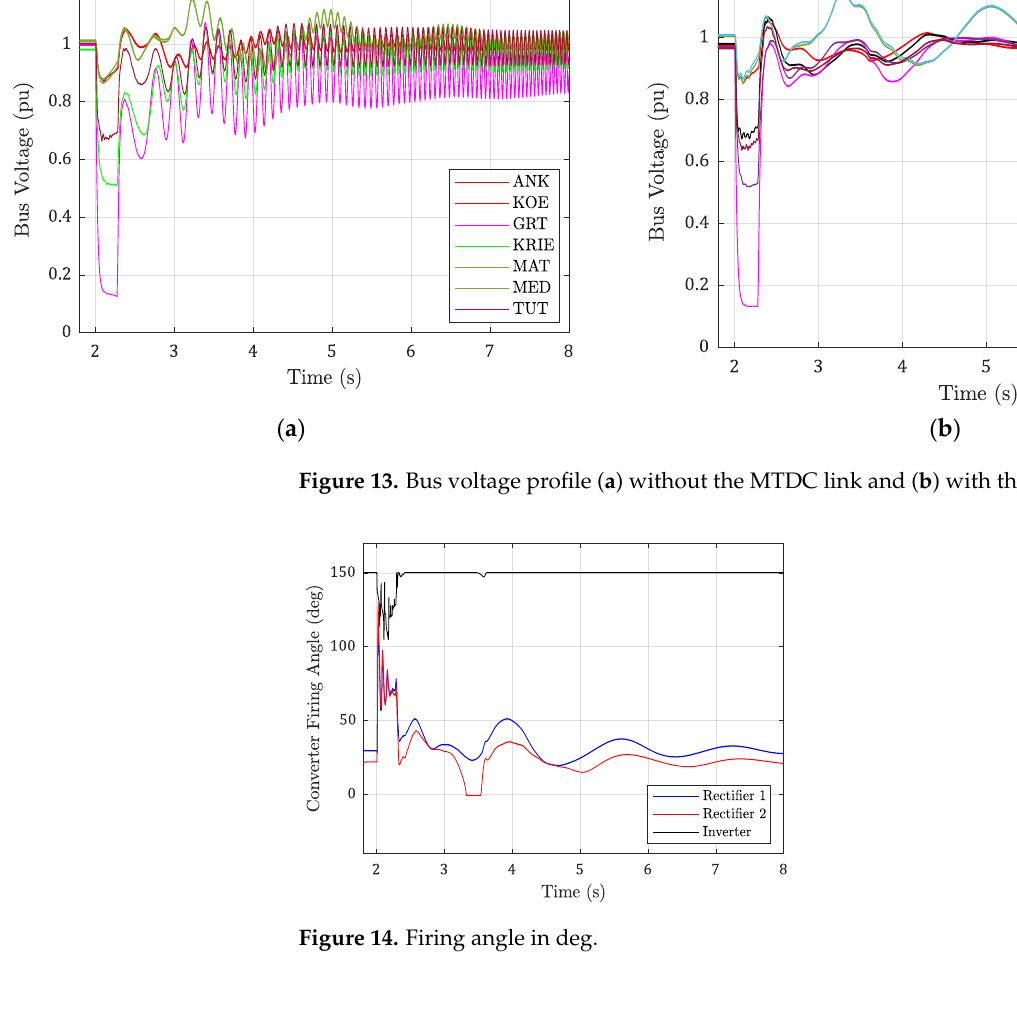
Figure 15. MTDC power where RP1 is rectifier 1 power, and ARP1 is rectifier 1 power with the auxiliary control. Figure 16. Interarea power transfer across the northern and north-east borders. Figure 11a,b show the generator rotor angle ( δ ) dynamics in radian. In Figure 11a, the GRT_PS synchronous generator was out of step from the rest of the synchronous machine. It recorded a rapid increase in the rotor angle, while other generators witnessed a steady increase with the continuous oscillation. These generators, having yielded their excitation and AVR controls, remained unsta- ble even after clearing the fault due to insufficient decelerating torque to reduce the rotor speed, i.e., the generators exhibited positive damping ( T D ) torque but with a negative syn- chronizing torque ( T S ), causing a non-oscillatory instability. The unstable state involving the rotor angle speed is usually referred to as electromechanical oscillations. The control systems are intended to restore the power system to stable conditions and to align the mechanical torque with the electromagnetic torque of each generator, thereby ensuring